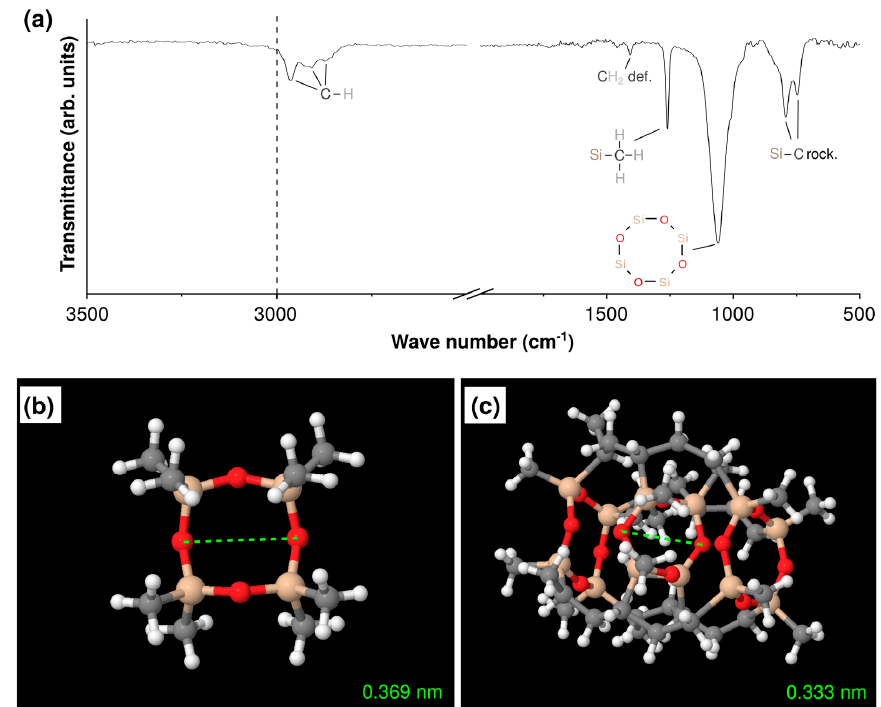
Figure 3. Chemical characterization and theoretical estimation of PV4D4 ring structures. ( a ) The infrared bands measured for the deposited PV4D4 thin films via FTIR show preserved functionality of all functional groups as well as successful polymerization; ( b ) isolated D4 molecule geometry optimized using DFT on the B3LYP / 6-31G* level; and ( c ) embedded V4D4 molecule connected at all sites only to one other V4D4 molecule geometry optimized via DFT.